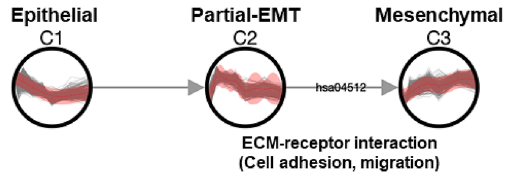
Figure 4. Cluster network of human EMT dataset inferred by